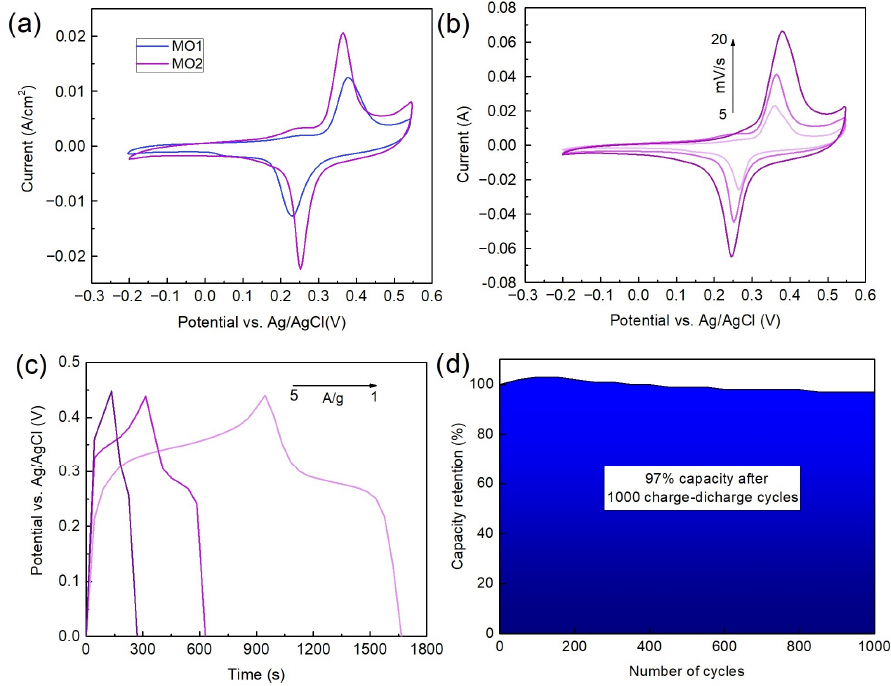
Figure 5. CVA curves of MO1 and MO2 ( a ); CVA curves at several scan rates ( b ) of MO2; GCD at several current density curves ( c ) of MO2; cycling stability of MO2 (at 5 A/g) ( d ).